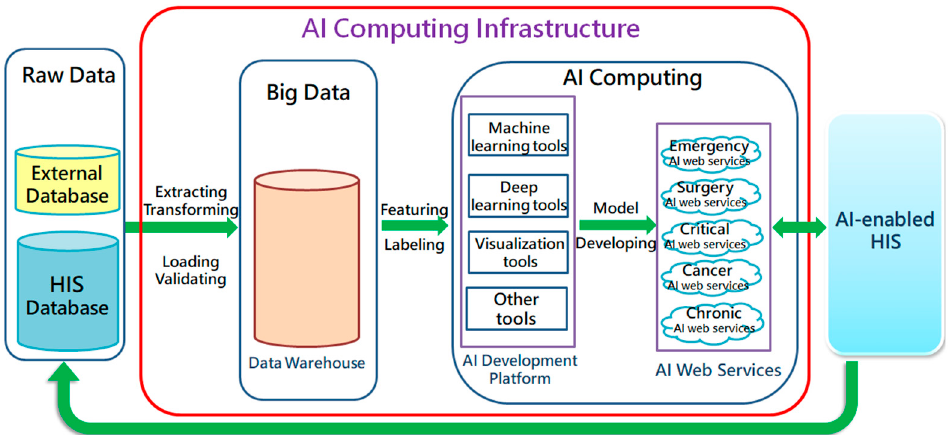
Figure 1. AI Computing Infrastructure of Chi Mei Hospital.